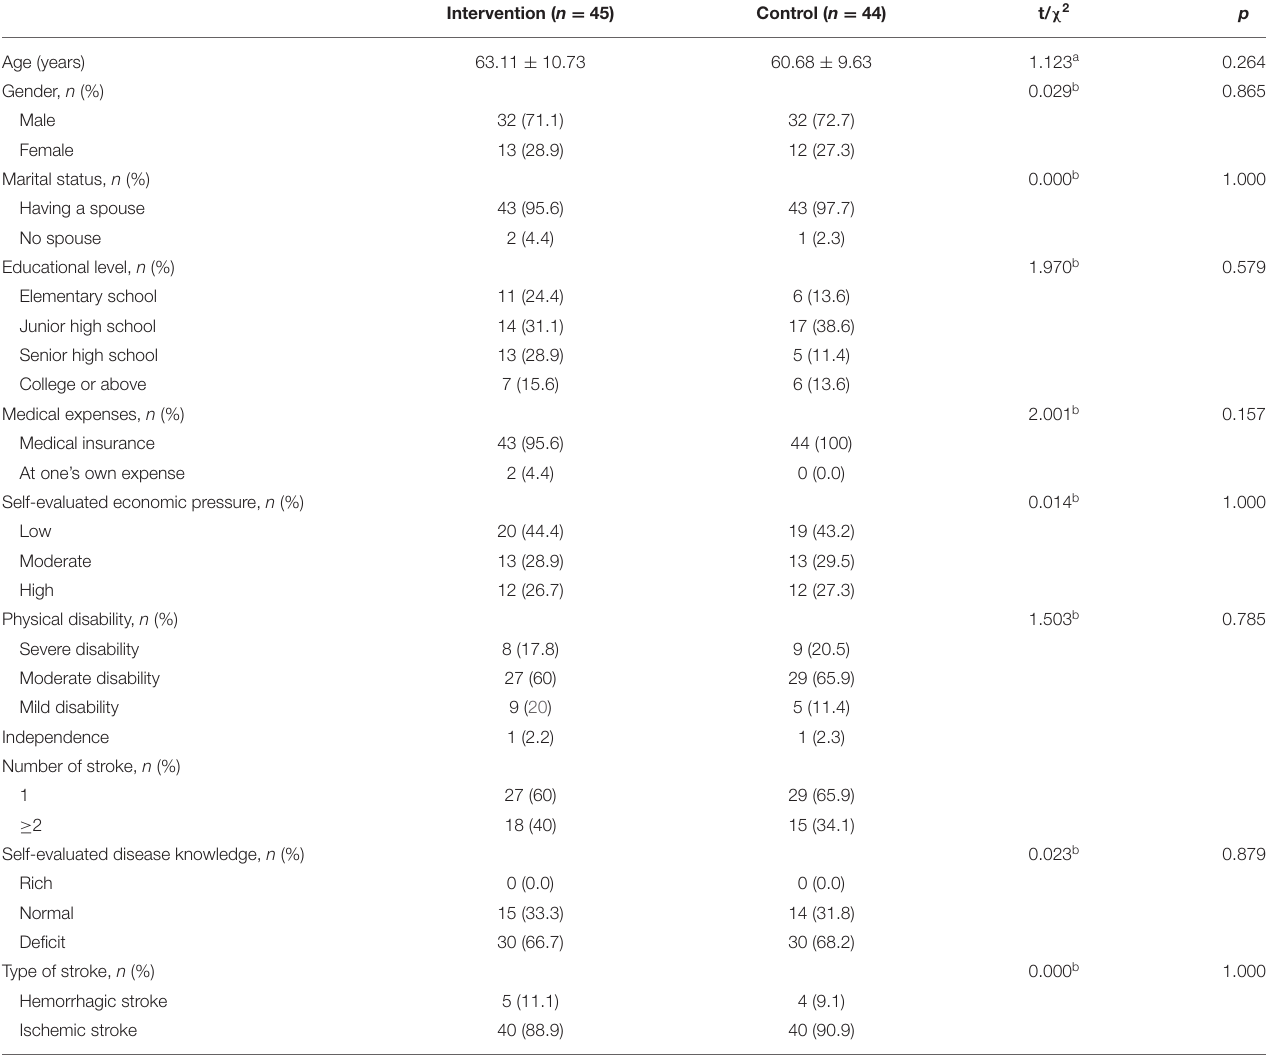
TABLE 2 | Characteristics of participants at baseline ( n ,